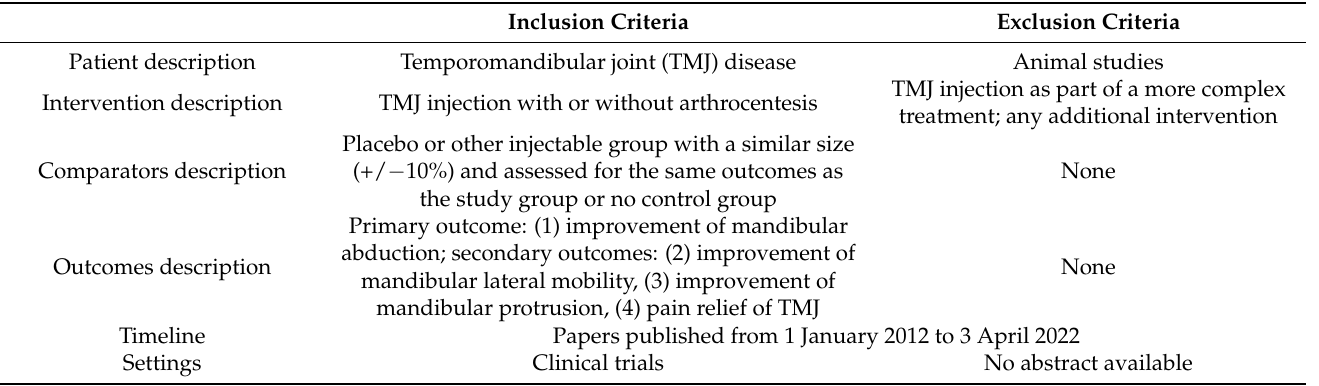
Table 1. Criteria for including and excluding studies from the